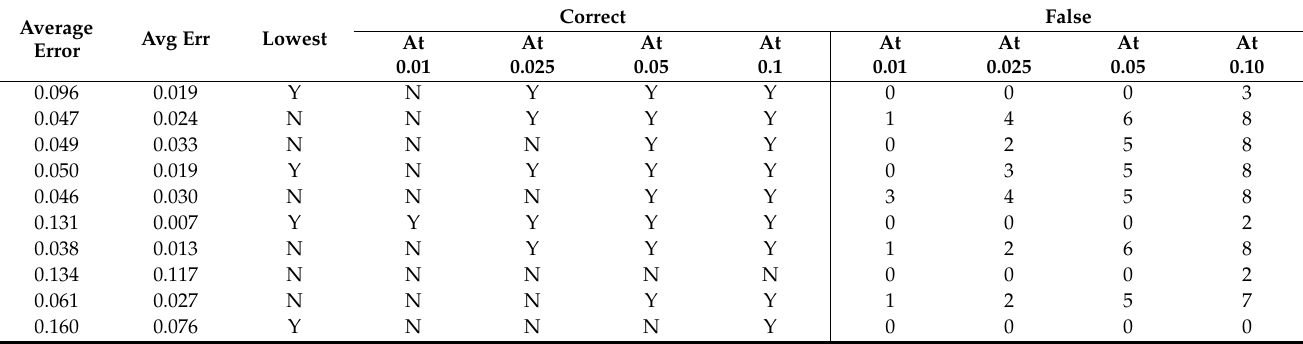
Table A137. Set 2, trials 31–40 summary data (single 0.5 PR